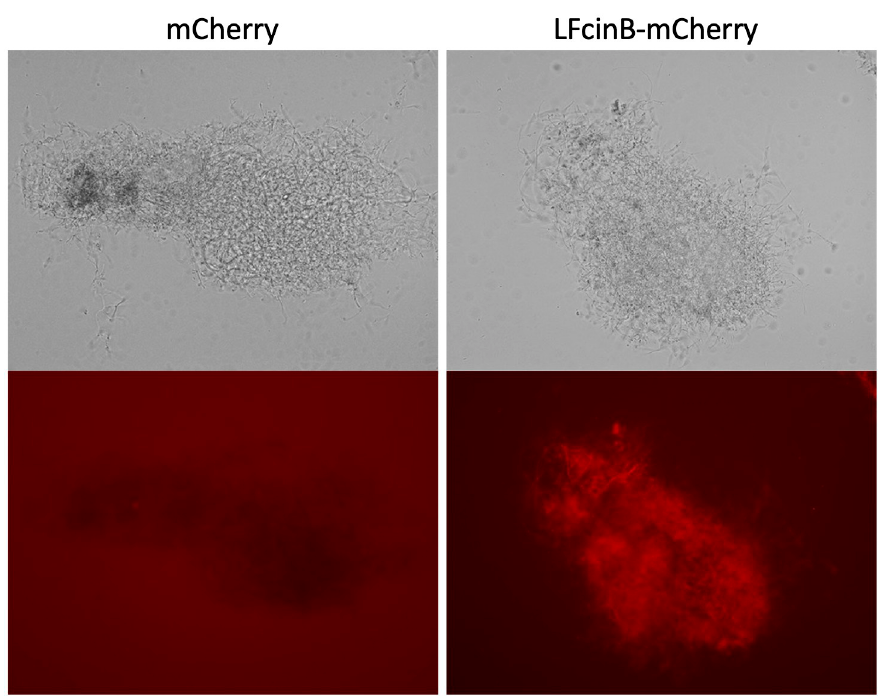
Fig 5. The ability of bovine-derived lactoferrcin (LFcinB) to bind to the cell surface of Streptomyces scabiei S58. LFcinB and the fusion protein of mCherry-LFcinB (red fluorescence) were expressed in Escherichia coli respectively and adjusted to the concentration of 75 μ g/mL before treatment against the pseudohyphal cells of S . scabiei . The fluorescent image of mCherry-treated cells (lower left) was taken at a longer exposure time (3 s) than that of mCherry- LFcinB-treated cells (1/2 s) (lower right). Upper images were taken in the bright field.